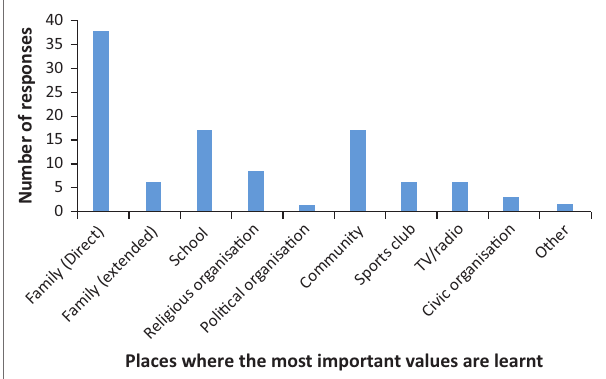
Respect Honesty/integrety Healthy lifestyle Tolerance Responsibility Discipline Self-esteem(love) Fairness Inclusivisity/inclusion Team work/coopera(cid:141)on Perseverance/determina(cid:141)on